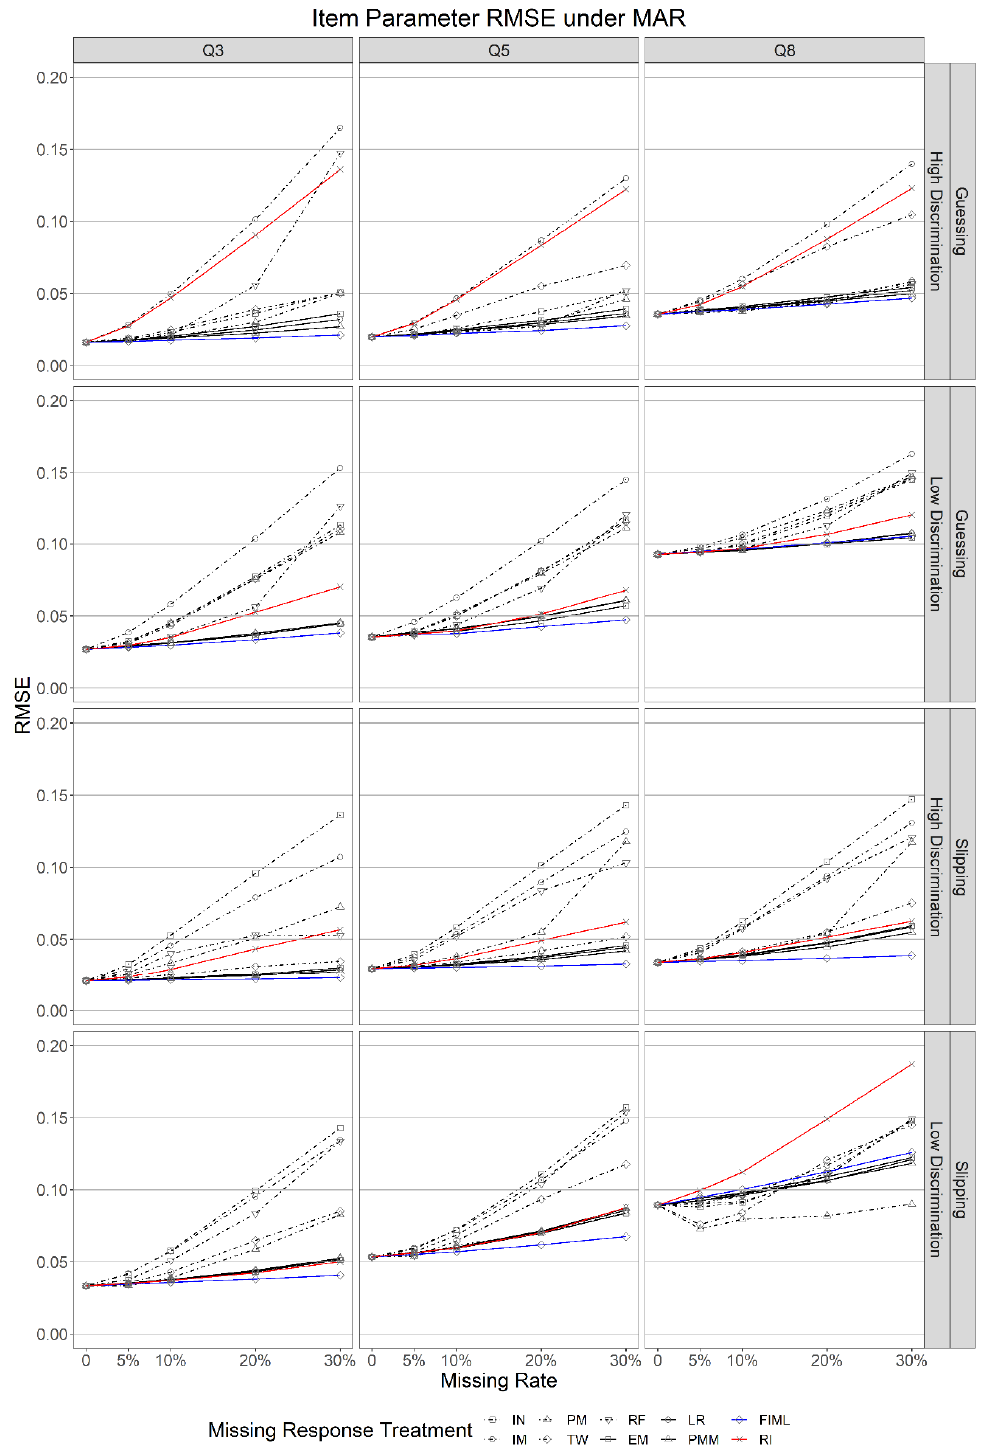
by dotted lines (with different shapes), while the EM, LR, PMM, FIML, and RI methods are represented by solid lines. The two baseline-of-comparison methods, RI (solid red lines with crosses) and FIML (solid blue lines with diamonds), are color-coded for better visualization of the results.